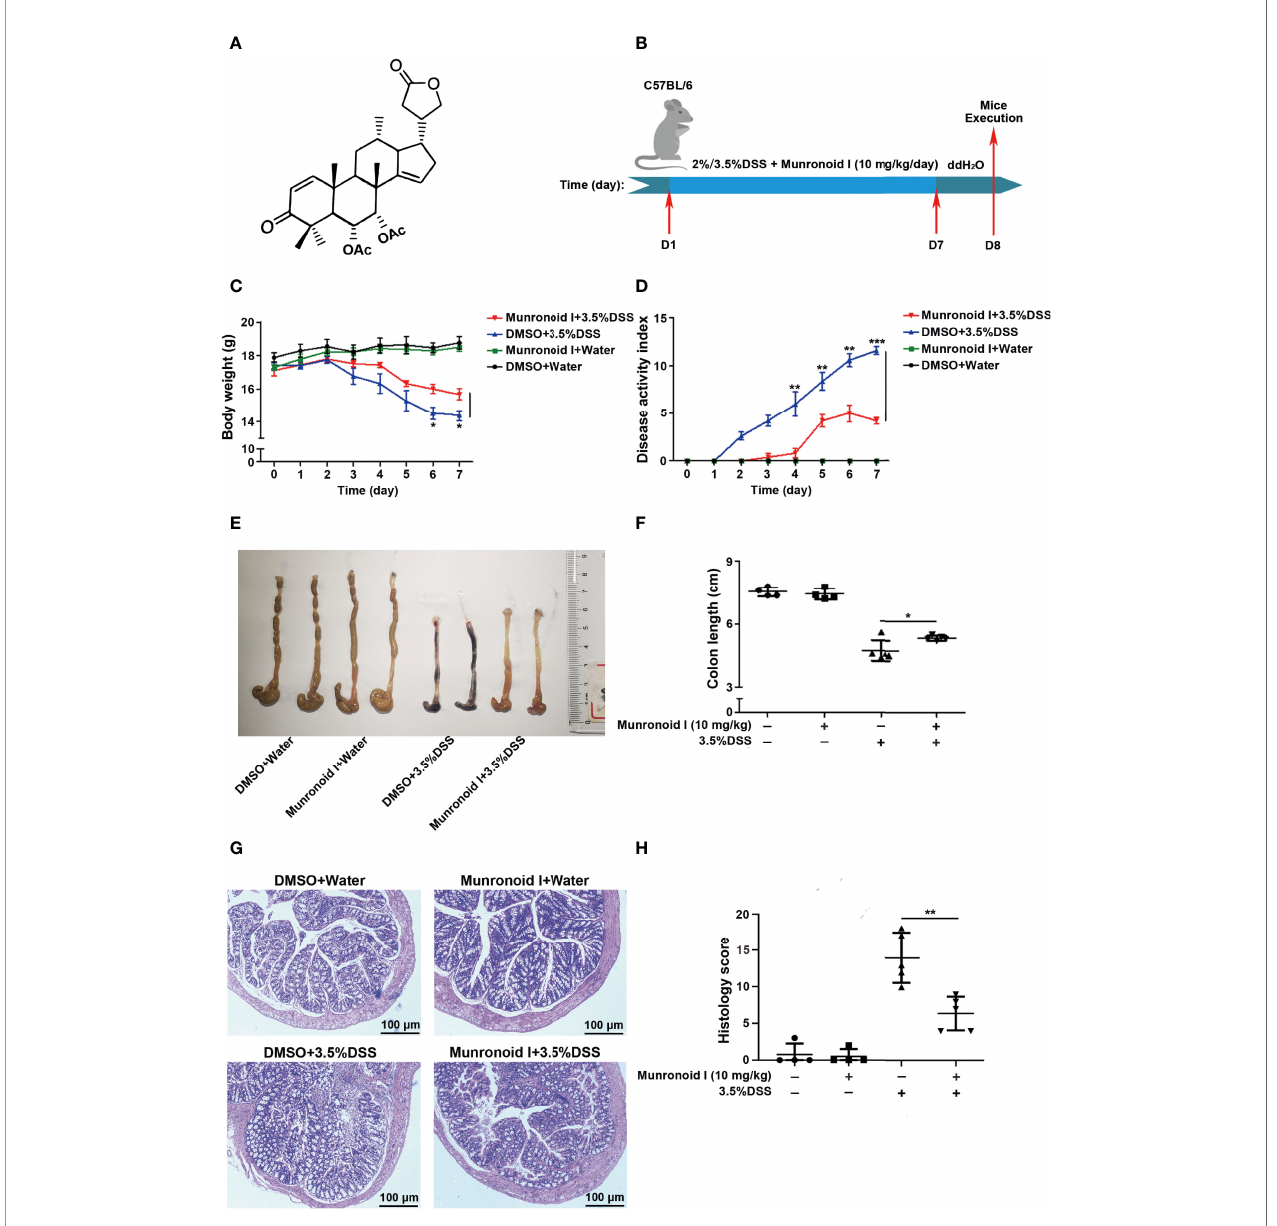
FIGURE 1 | Munronoid I relieves the severity of DSS-induced colitis in mice. (A) The chemical structure of Munronoid (I) (B) Overview of the experimental protocol. C57BL/6 mice (n = 4 – 5 mice/group) were fed with distilled water or water containing 3.5% DSS and were intragastric injected with DMSO or Munronoid I (10 mg/kg) daily. Seven days later, all the water was changed to distilled water, on the 8th day, the mice were sacri fi ced, and their colon tissue was collected. (C, D) The body weight (C) , stool consistency, and gross rectal bleeding were recorded every day to calculate the DAI score (D) . (E) Colons of mice were assessed at the time of necropsy with representative macroscopic images. (F) The colon length was measured and statistical signi fi cance determined by unpaired Student ’ s t-test. (G) H&E staining of colon sections (10X) and representative H&E images scored in (H) . Data in C, D, F and H presented as the mean ± SD. *p<0.05, **p<0.01,